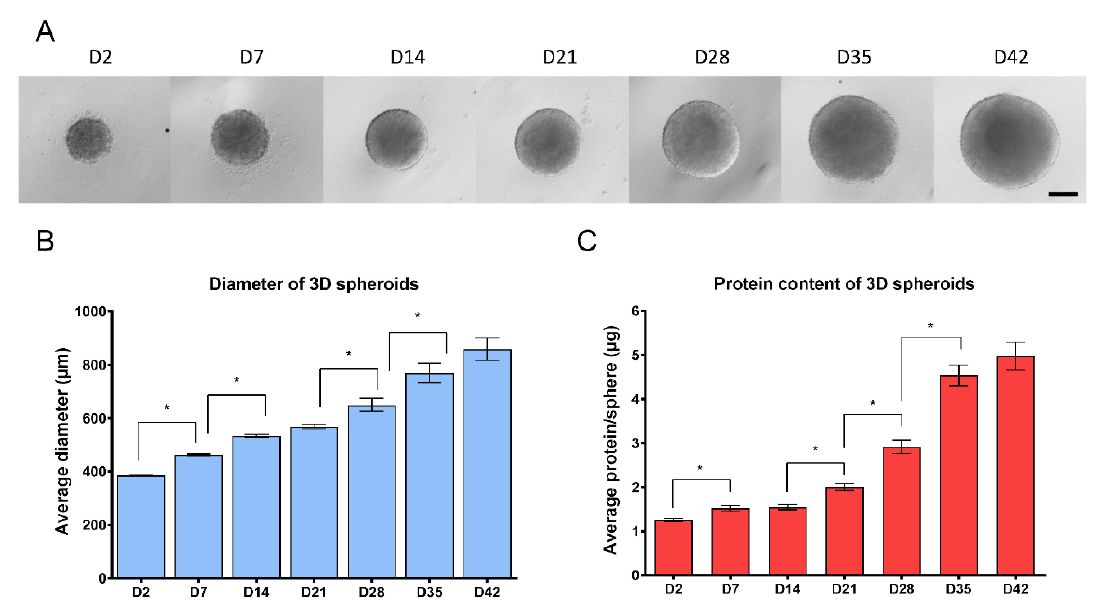
Figure 1. Growth properties of 3D neurospheres during the 6 weeks of differentiation ( A ) Representative microscopic view of 3D spheroids, investigated at weekly intervals (4×, scale bar: 200 µm). ( B ) The average diameter of 3D spheroids in µm measured by CellSens Dimension software (Olympus) ( n = 3, in each experiment 96 spheroids were compared weekly trough 6-weeks). ( C ) Average total protein content of spheroids determined by Pierce BCA Protein Assay. Note that D2, D7 and D14 samples were measured by pooling three spheroids and individual values were calculated, while in all other timepoints spheroids were measured individually ( n = 3, in each stage 24 spheroids were measured). ±SEM values are presented on graphs. (* p < 0.05).